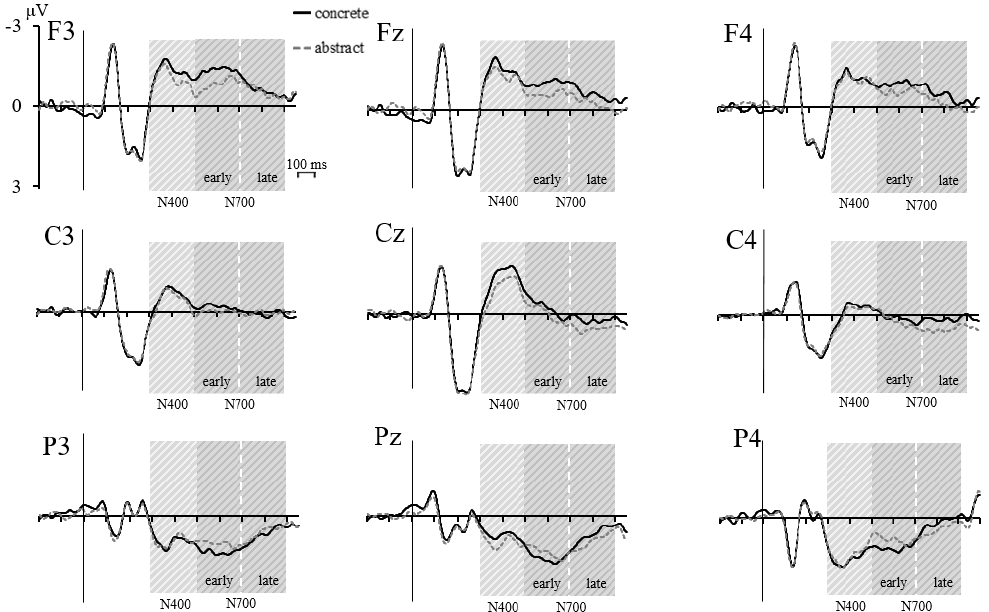
Figure 2. Real word ERPs. Grand averages ( n = 21) of the ERP waveforms elicited by concrete and